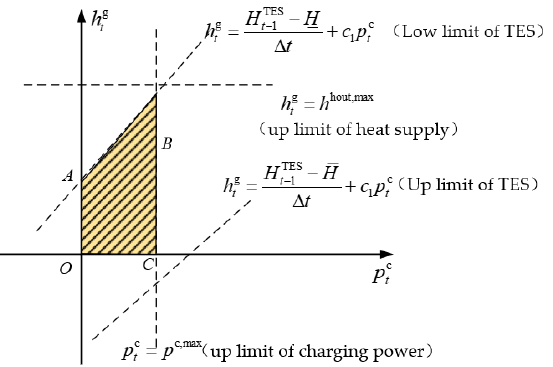
Figure 6. The operationally feasible region of the SA-CAES under the charging–heating mode.